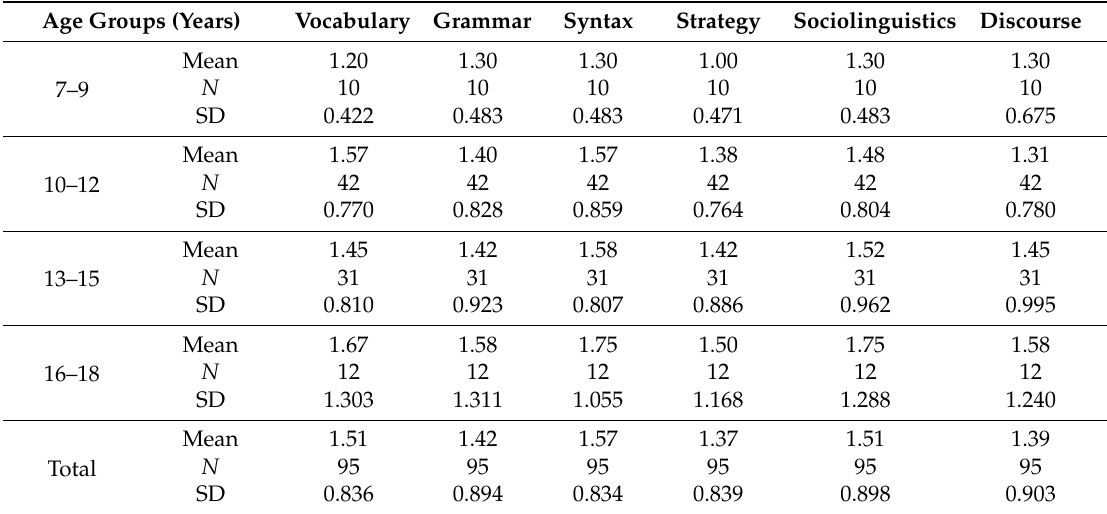
Table 2. Analysis of performance considering age